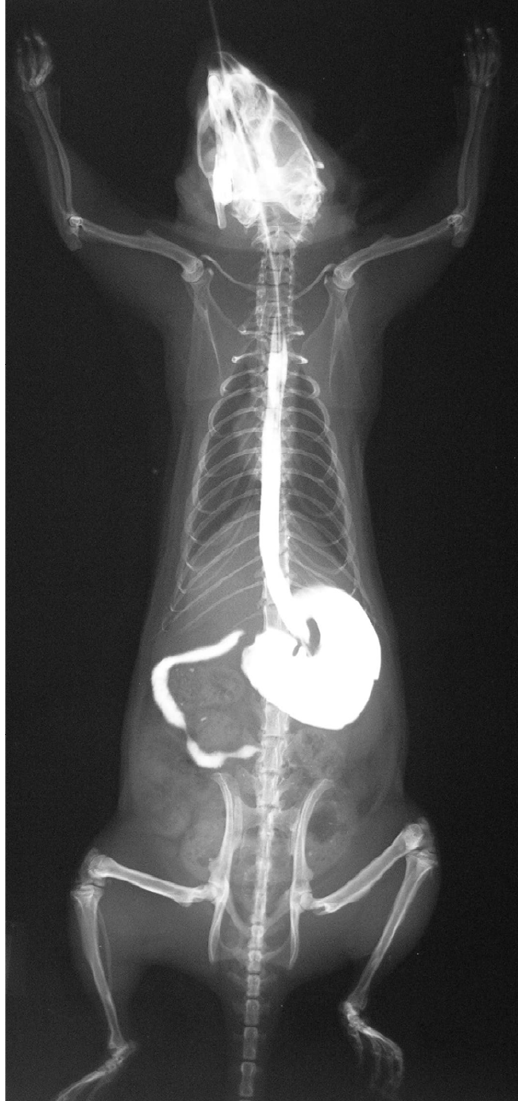
FIGURE 3 - Superimposition of the abdominal quadrants in the anteroposterior incidence